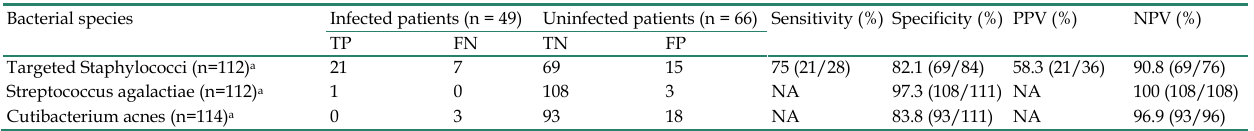
Table 3. Performances of serological tests according to cultures Bacterial